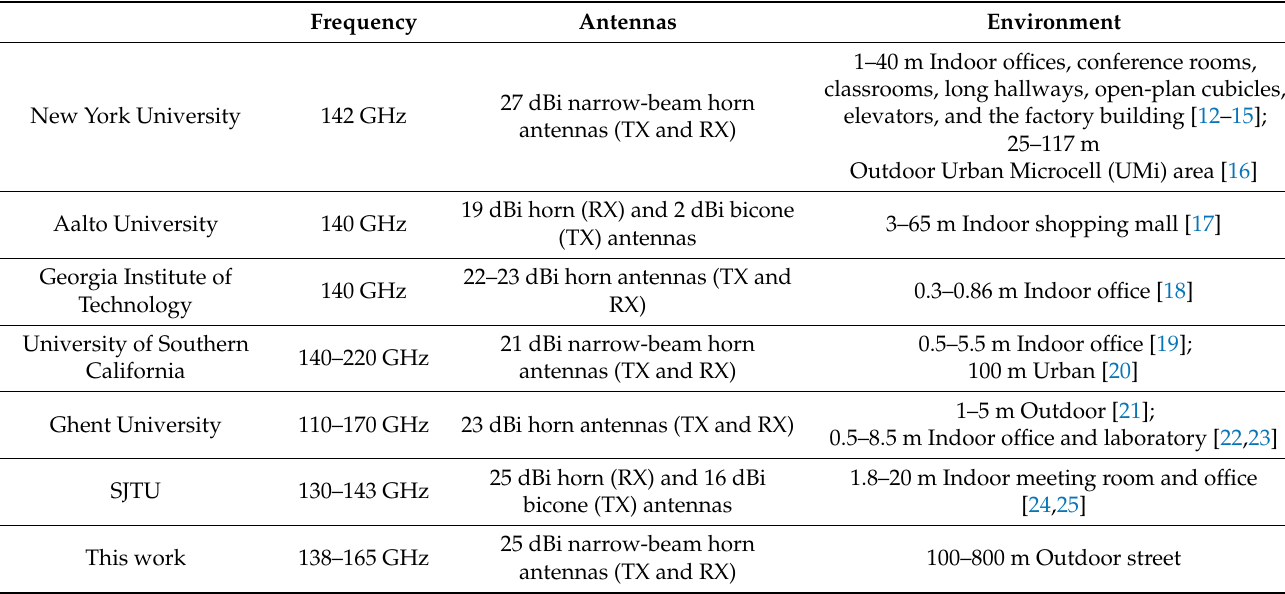
Table 1. Reference Review of Exploring Channel Characteristics.